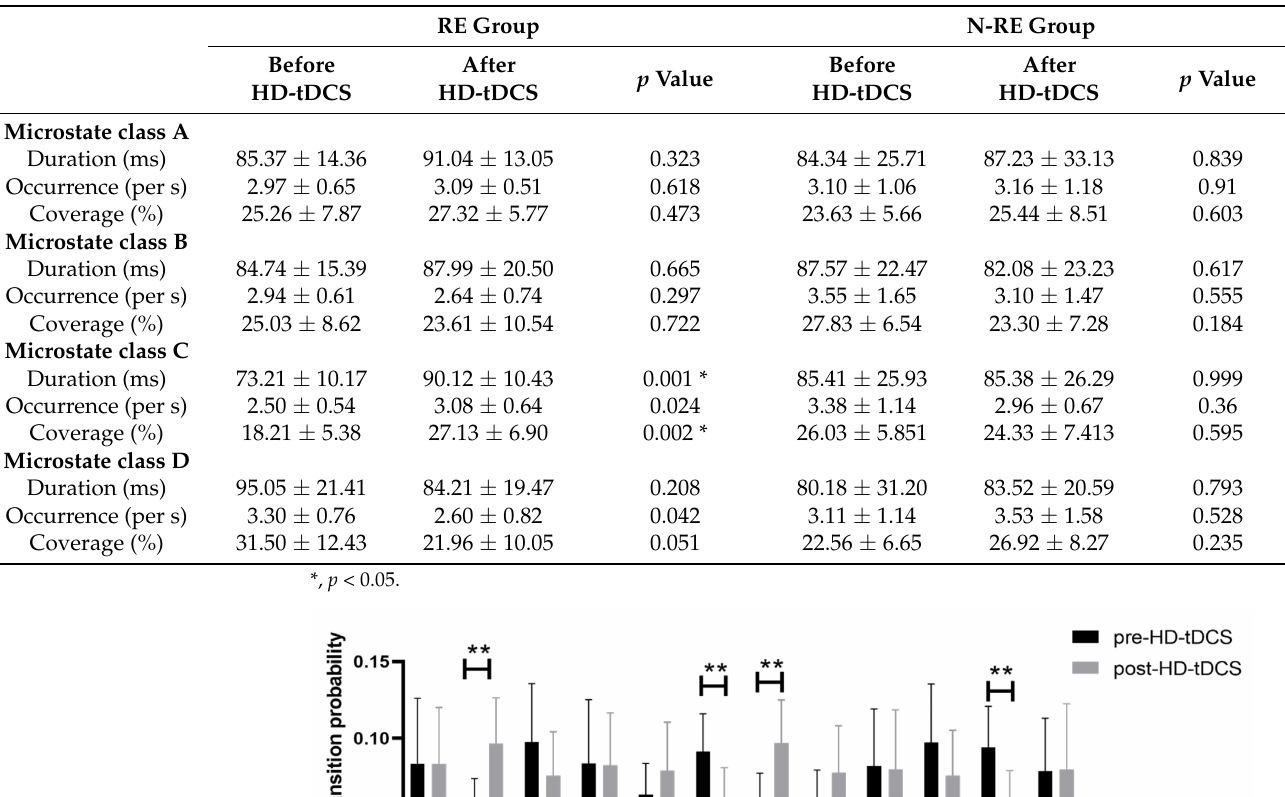
Table 2. Microstate parameter changes following HD-tDCS in responsive and non-responsive patients.